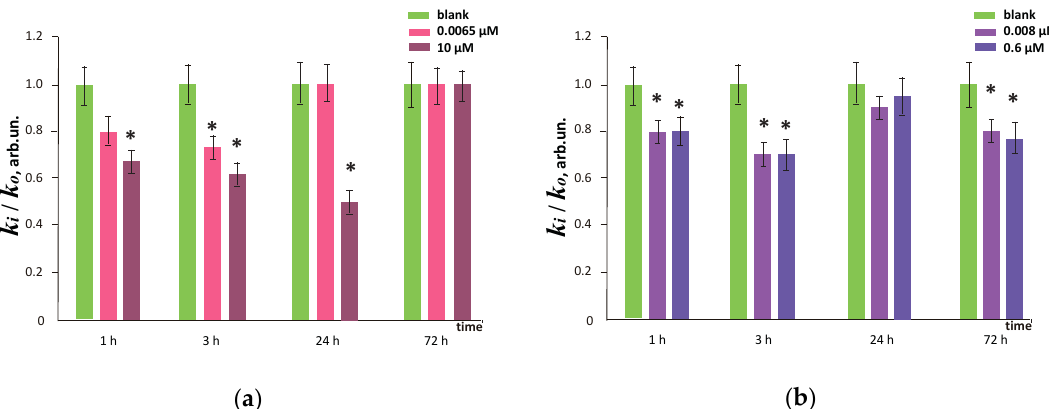
Figure 7. Reactive oxygen species (ROS) levels in cells expressed as a ratio of DCF synthesis rate constants after fullerene exposure— k i and in blank— k 0 at various ( a ) FF1 and ( b ) FF2 concentrations and time of incubation (indicated in figure). * means that the results differ significantly from the blank (the cells cultured without the fullerenes) according to the Mann–Whitney test ( p < 0.05). In blank experiments, cells were incubated without the fullerenes.